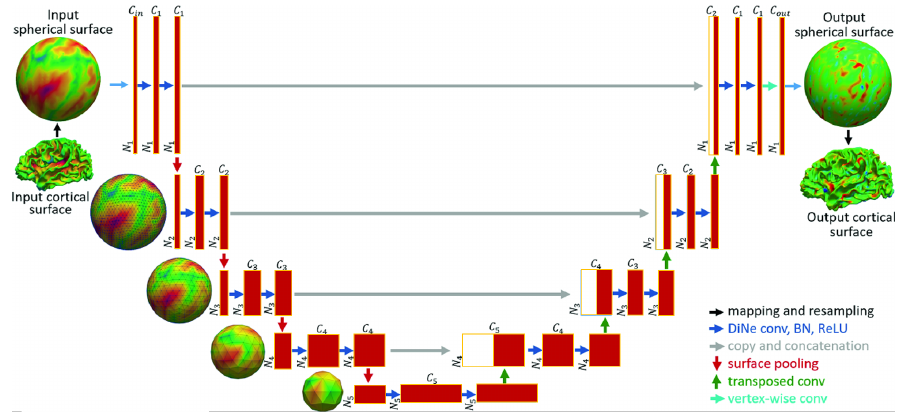
Figure 11. Spherical UNet architecture. The output surface is a cortical parcellation map or a cortical attribute map, and the blue boxes reflect feature maps in spherical space. Note that all spherical surfaces in this figure have the same real size. Image adapted from